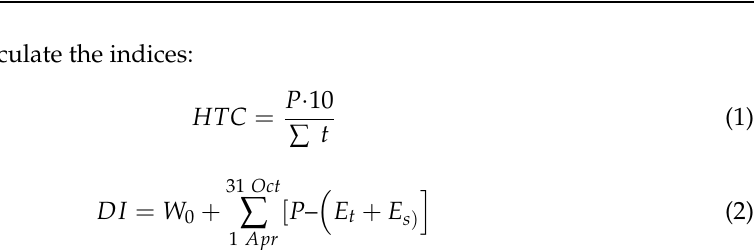
Table 1. Classes of indices used in the paper.